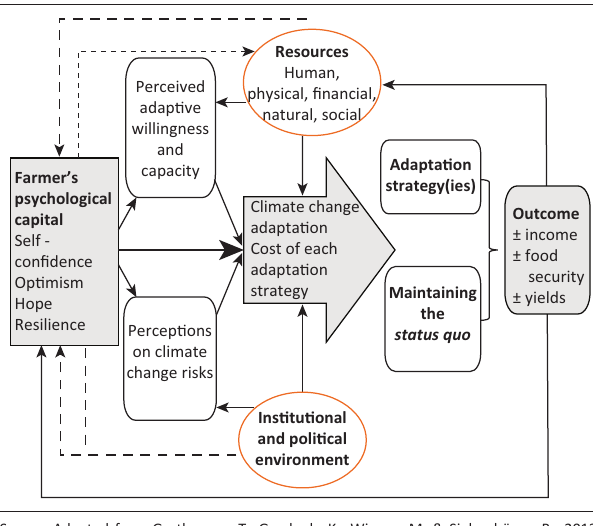
FIGURE 1: The psychological capital model of adaptive behaviour to climate